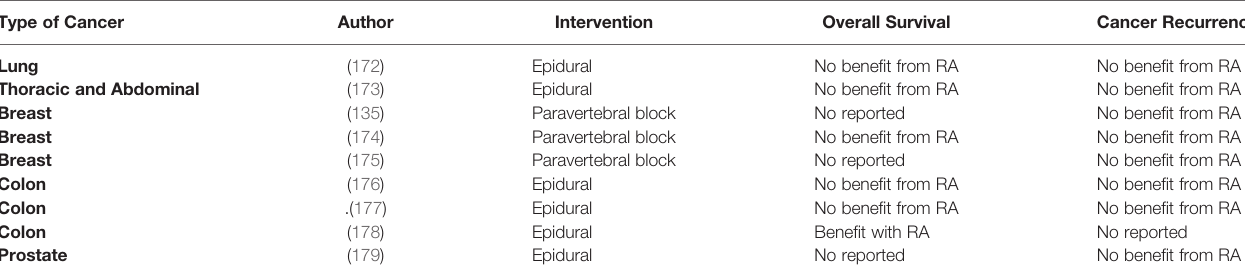
TABLE 4 | Randomized control trials assessing the effect of regional anesthesia on long-term cancer